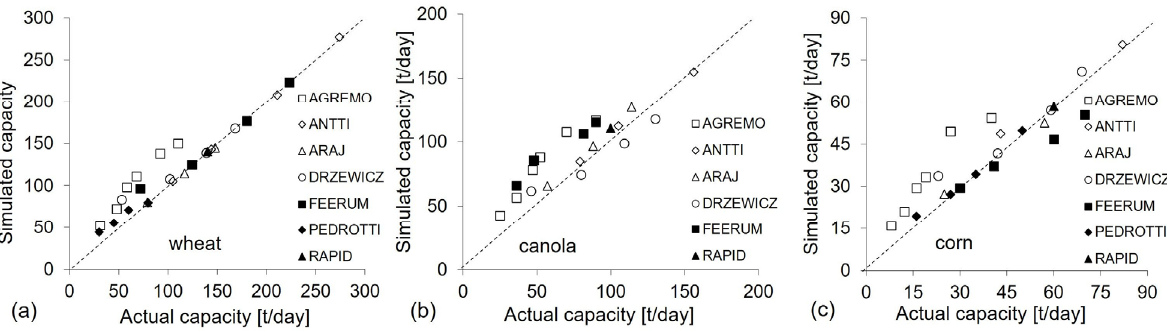
Figure 8. A comparison of the simulated daily capacity of selected batch dryers with their actual capacity. ( a ) Wheat; ( b ) canola; ( c ) corn.